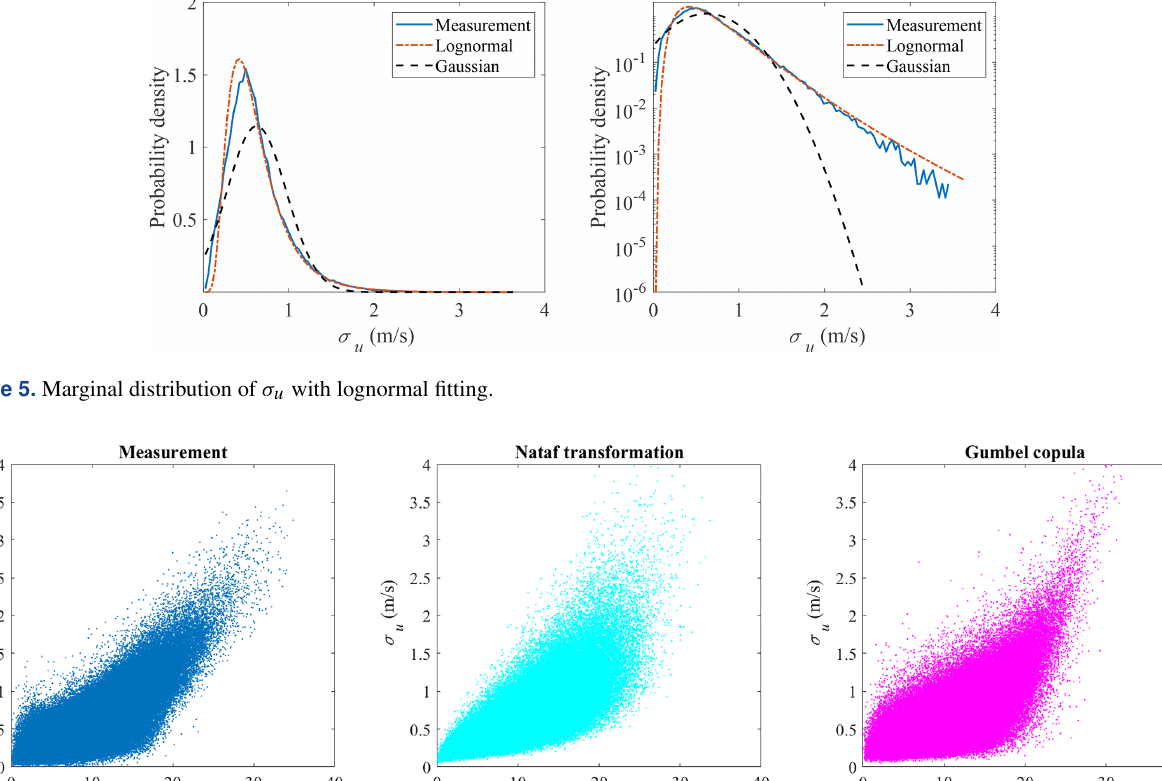
wind speeds. The differences in the conditional distribution between the copula-estimated and measurement data indicate estimation and large model uncertainty for DLC 1.3 simula-